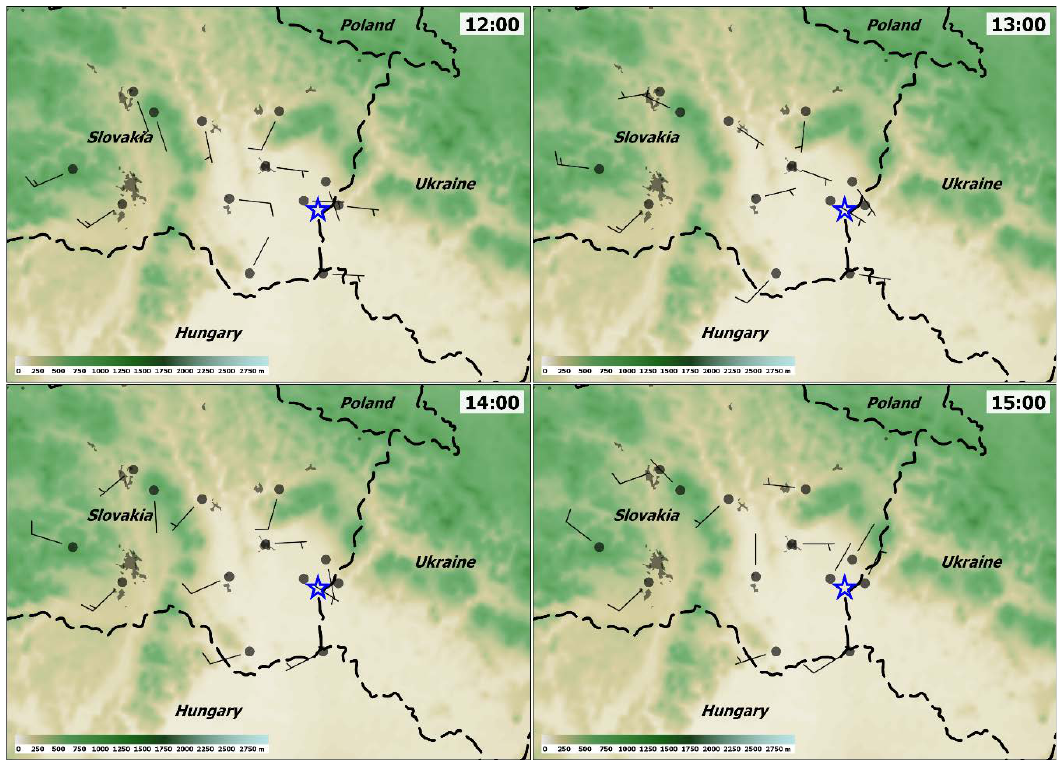
Figure 8. Surface-wind observations on 3 October 2018, 12:00–1500 UTC based on synoptic reports. Country names shown in italics; tornado location highlighted by blue star.